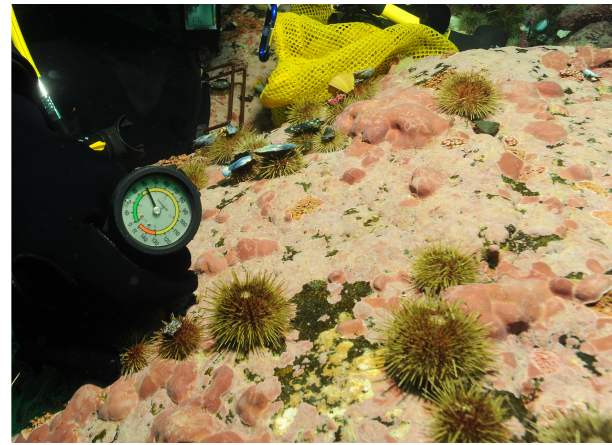
Figure 2. Clathromorphum compactum mounds (dark red) up to 3cm thick in a typical coralline community at 13m depth off Quirpon Island in northernmost Newfoundland. Photo by Nick Caloyianus.